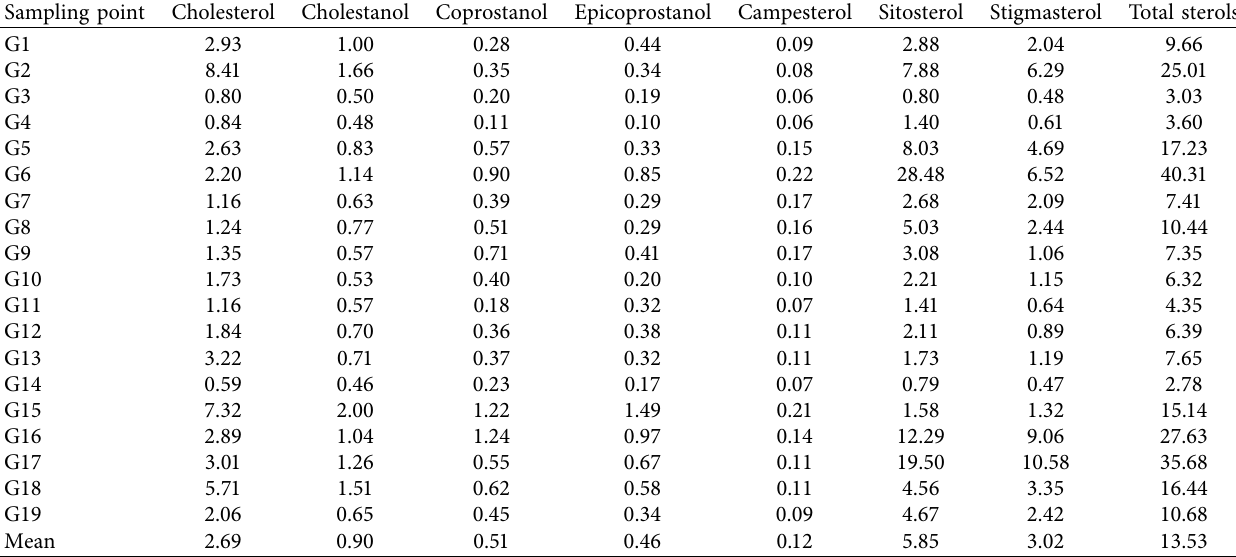
Table 3: Sterol concentrations in sediments of the Guanting Reservoir ( μ g g − 1 ).